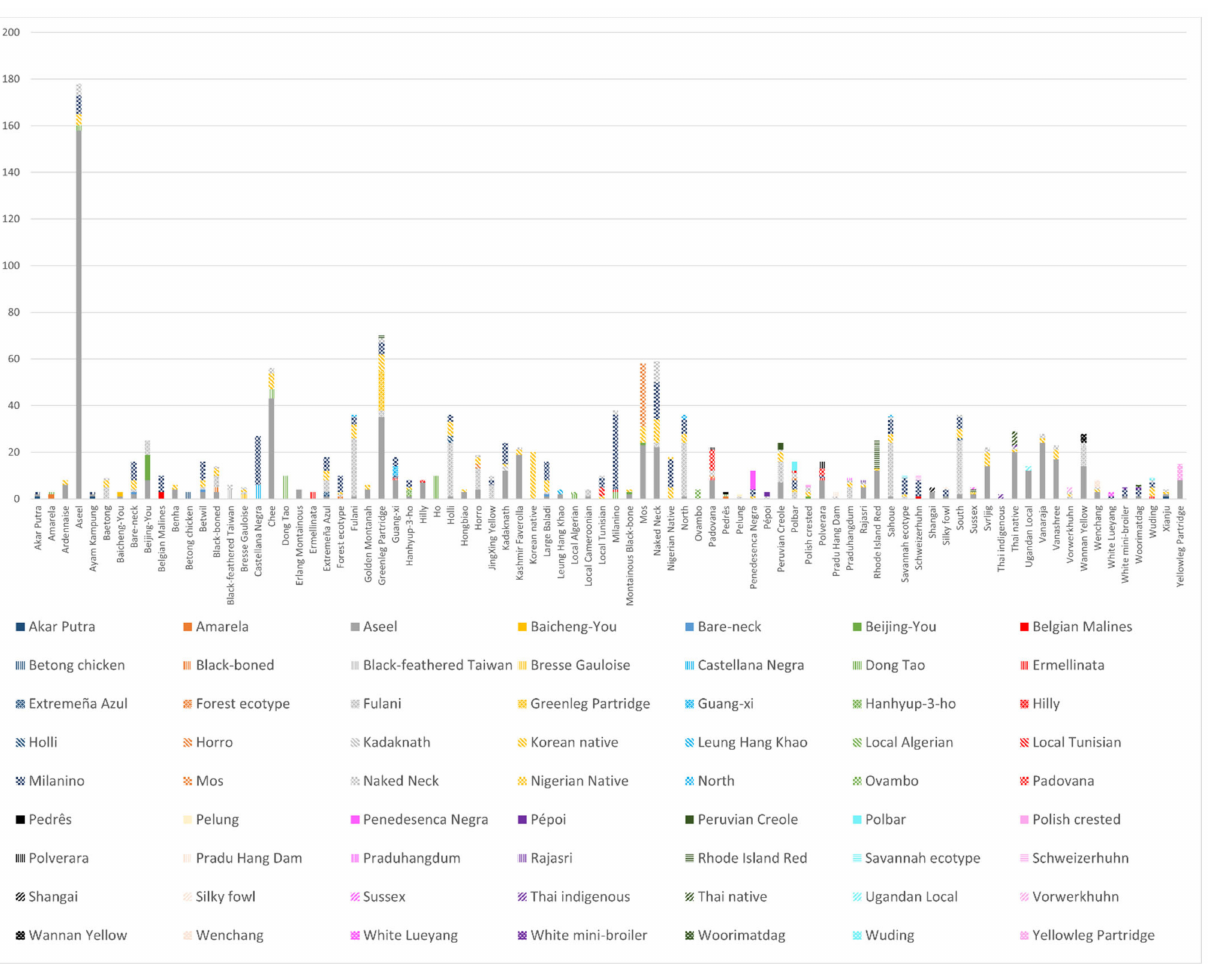
Figure 3. Graphical depiction of the prior and posterior classification of observations depending on their